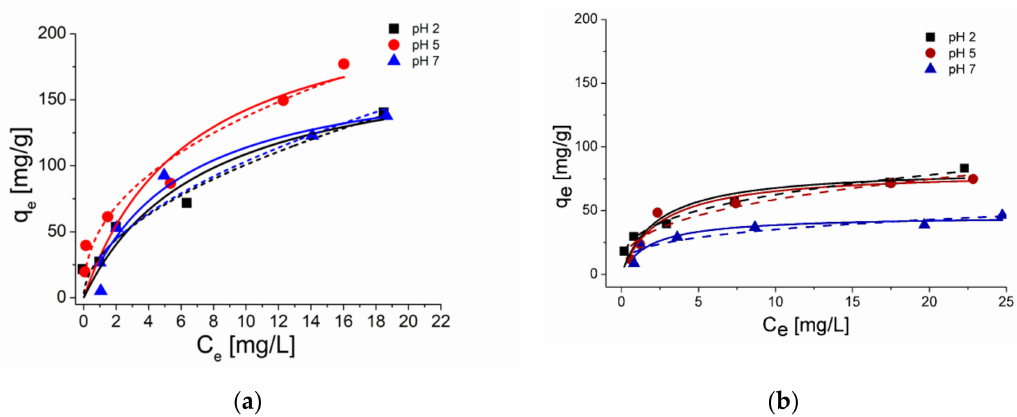
Figure 3. Langmuir (solid line) and Freundlich (dashed line) isotherms for the SMT adsorption onto ( a ) SWCNTs and ( b ) MWCNTs in the presence of β -cyclodextrins (BCD) in a phosphate bu ff er at pH 2, 5, and 7. Table 3. Adsorption isotherm parameters ( ± SEM) obtained from experimental data fitted with Langmuir and Freundlich models (Equations (1) and (2)) for the adsorption of SMT onto SWCNTs and MWCNTs in the presence of BCD in the aqueous solution at pH 2, 5, and 7. SMT-BCD-CNTs